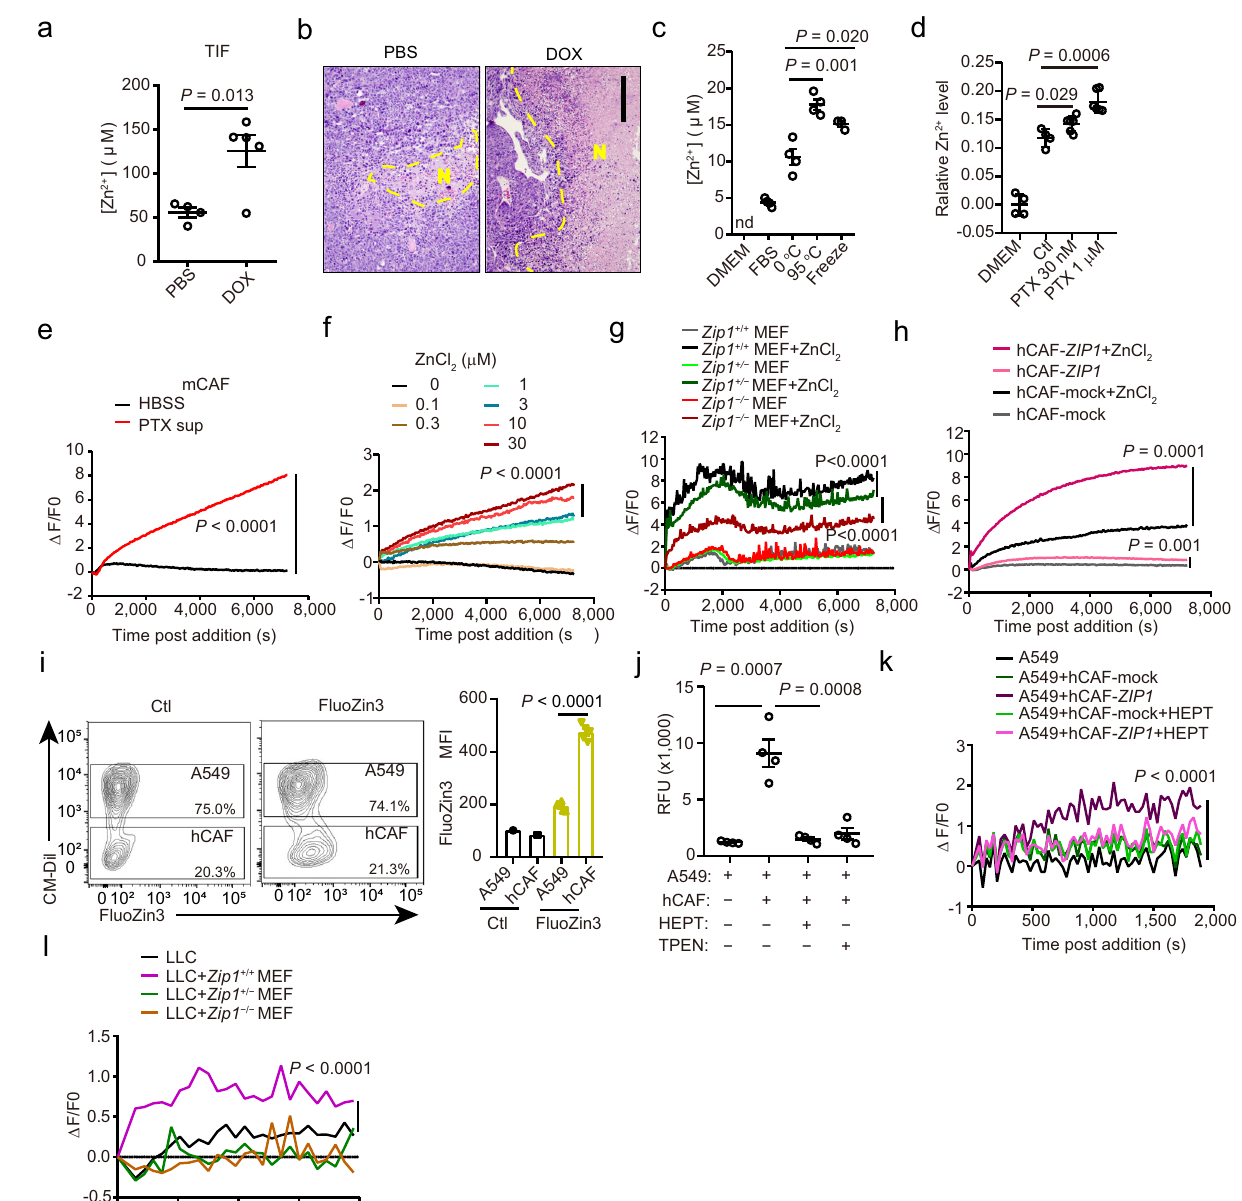
Fig. 3 | ZIP1 + fi broblasts absorb and transfer Zn 2+ to cancer cells through gap junctions. a Zn 2+ in tumour interstitial fl uid (TIF) from mice with PBS ( n =4) and doxorubicin (DOX, n =5) treatments. Mean±SEM, Two-tailed t -test. b Necrosis in tumourswithDOXtreatment.Nnecrosis.Scalebar,200 µ m.Arepresentativeresult from fi ve independent experiments is shown. c Zn 2+ released from dying tumour cells.LLCcells(1×10 7 )in50 μ Lculturemediumweretreatedat0°C,120min,95°C, 15min,or − 80°C,60min(freeze).nd,notdetectable.Mean±SEM, n =4.Two-tailed t- test. d Relative Zn 2+ levels in supernatants of PTX-treated LLC cells. Mean±SD, n =4 for DMEM and Ctl groups. n =6 for PTX groups. Two-tailed t -test. e Zn 2+ absorption by mCAF from the supernatant of PTX treated LLC cells. n =3. f Zn 2+ absorption by mCAF from extracellular space containing ZnCl 2 at indicated con- centrations. n =3. g Zn 2+ uptake by Zip1 +/+ , Zip1 +/ − and Zip1 − / − MEFs. ZnCl 2 , 30 μ M.